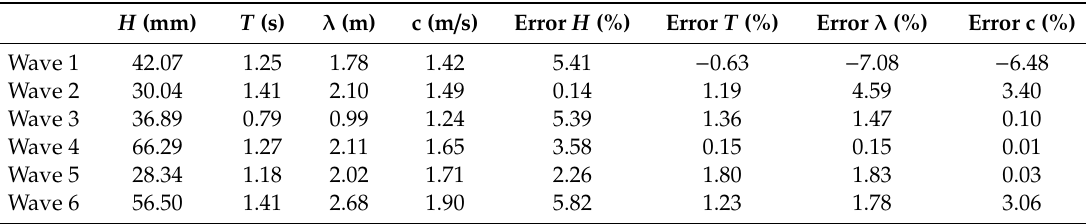
Table 2. Experimental results and relative errors of the incident wave with respect to the theoretically intended